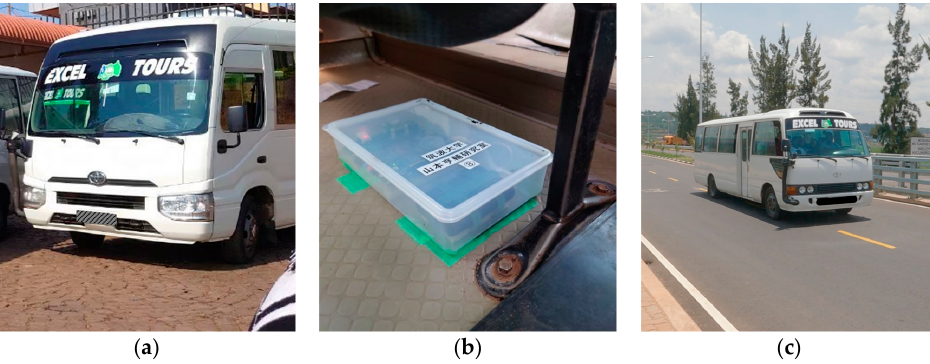
Figure 8. The bus for measurement: ( a ) the bus; ( b ) the sensor fixed to the floor inside the vehicle; ( c ) the bus in motion.